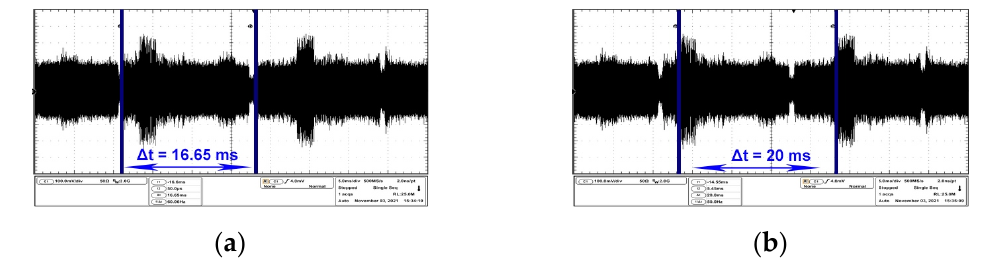
Figure 6. HP display: ( a ) frame period of 16.6 ms corresponding to an image containing a black image; ( b ) time interval between two emissions generated by the EUT’s AC power source measured at 20 ms.